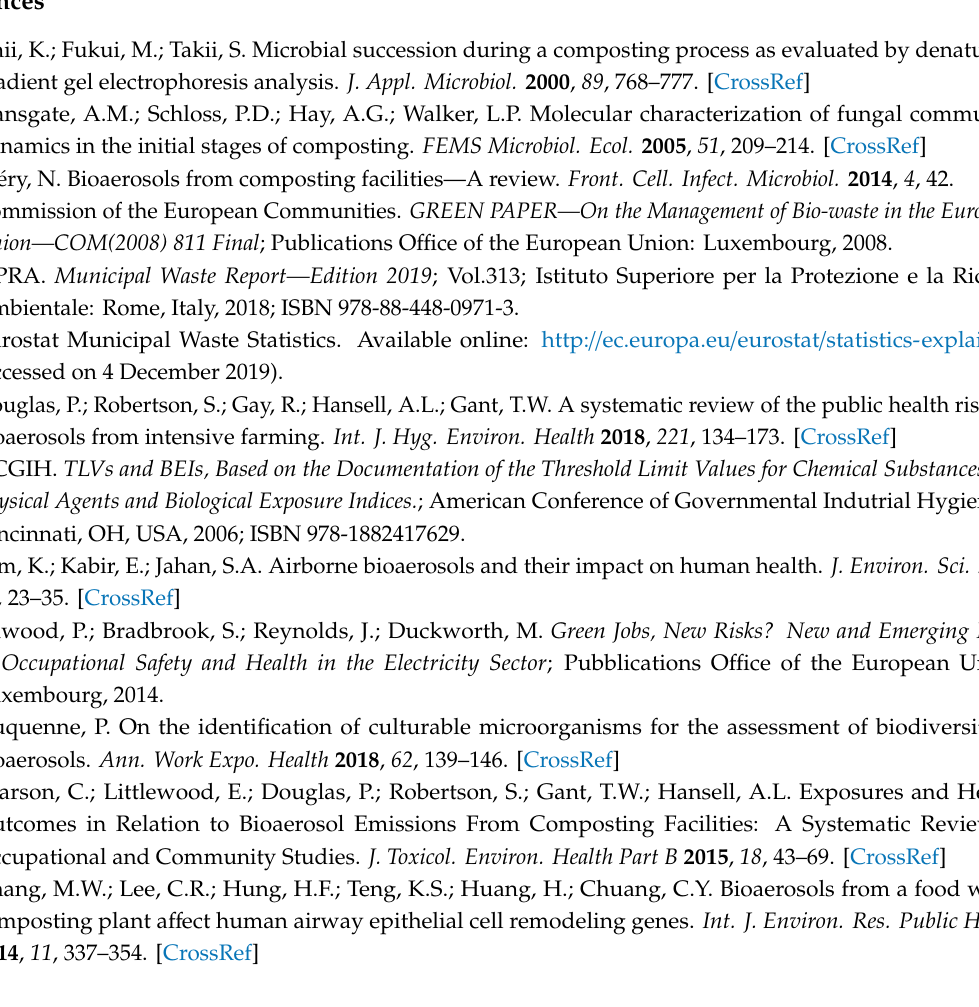
Table S1: Questionnaire submitted to the Italian composting plants; Table S2: Water management including collecting system, recovery system, and management for the three types of